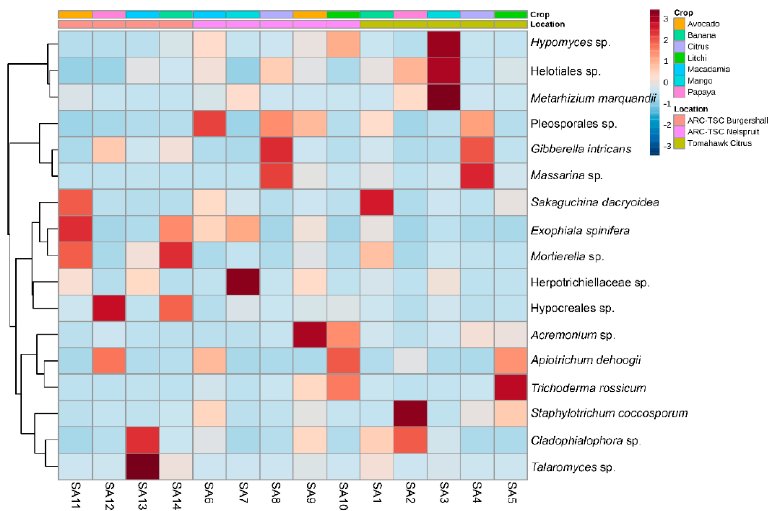
Figure 9. Hierarchical clustering illustrated by means of a heatmap and dendrogram for the 20 most abundant fungal taxa associated with the rhizospheres of 14 orchards sampled in Mpumalanga province, South Africa.